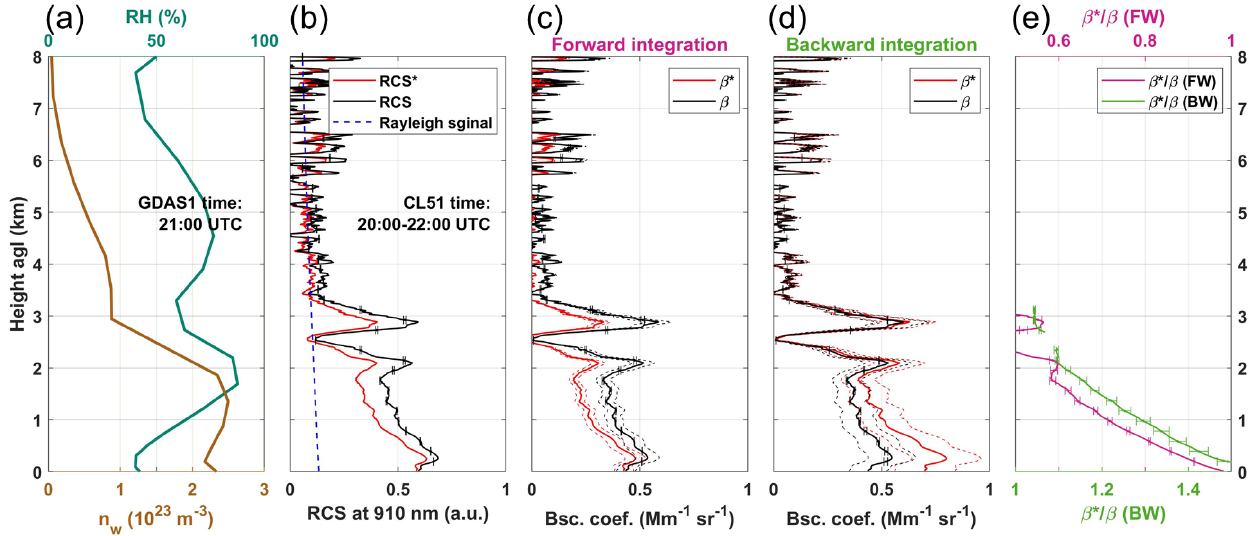
Figure 1. Example of water vapor corrections on 2h averaged ceilometer data on 5 June 2019 (20:00–22:00UTC). (a) Relative humidity (RH, teal) and water vapor number density ( n w , brown) from GDAS data at 21:00UTC. (b) Range-corrected signal at 910nm, without (RCS ∗ , red) or with (RCS, black) water vapor correction and the hypothetical Rayleigh signal at 910nm (dashed blue). (c) Retrieved particle backscatter coefficients: β ∗ without (red) and β with (black) water vapor correction, using forward (FW) integration Klett solution. (d) Same as (c) but application of the backward (BW) integration. (e) Ratio of the retrieved β ∗ and β , when using forward integration (magenta) or backward integration (green). The horizontal lines illustrate the uncertainty range due to wrong assumptions of the central wavelength λ 0 ± 2nm. The uncertainties in backscatter coefficients of the analytical solution were shown by dashed